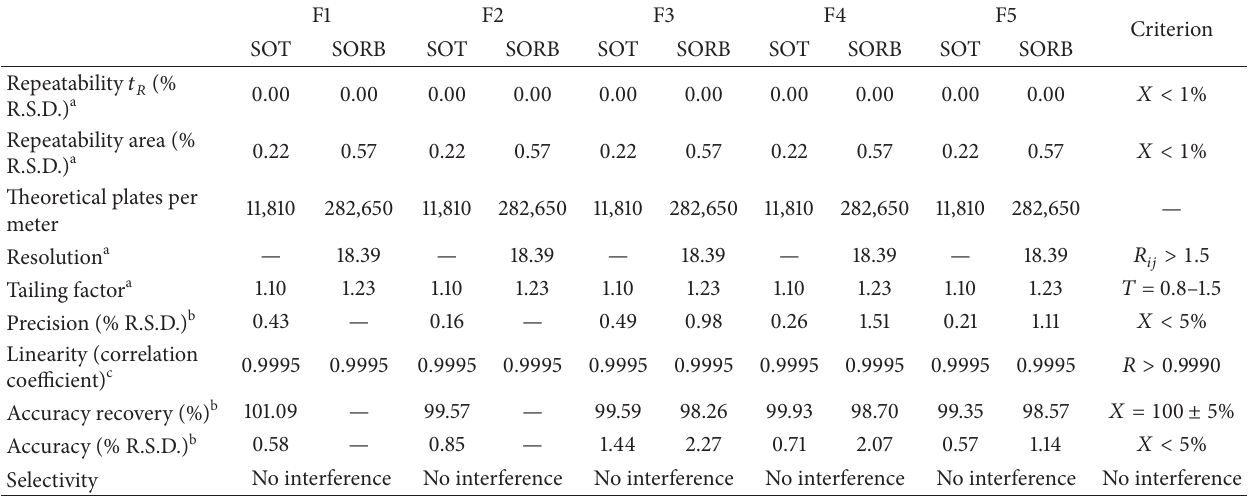
Table 3: Validation parameters of formulations